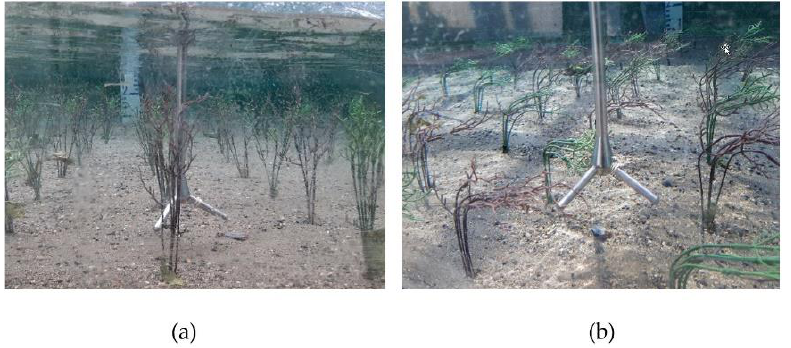
Figure 5. ADV position between two vegetation elements in ( a ) non-bending vegetation setting; ( b ) deflected vegetation setting.